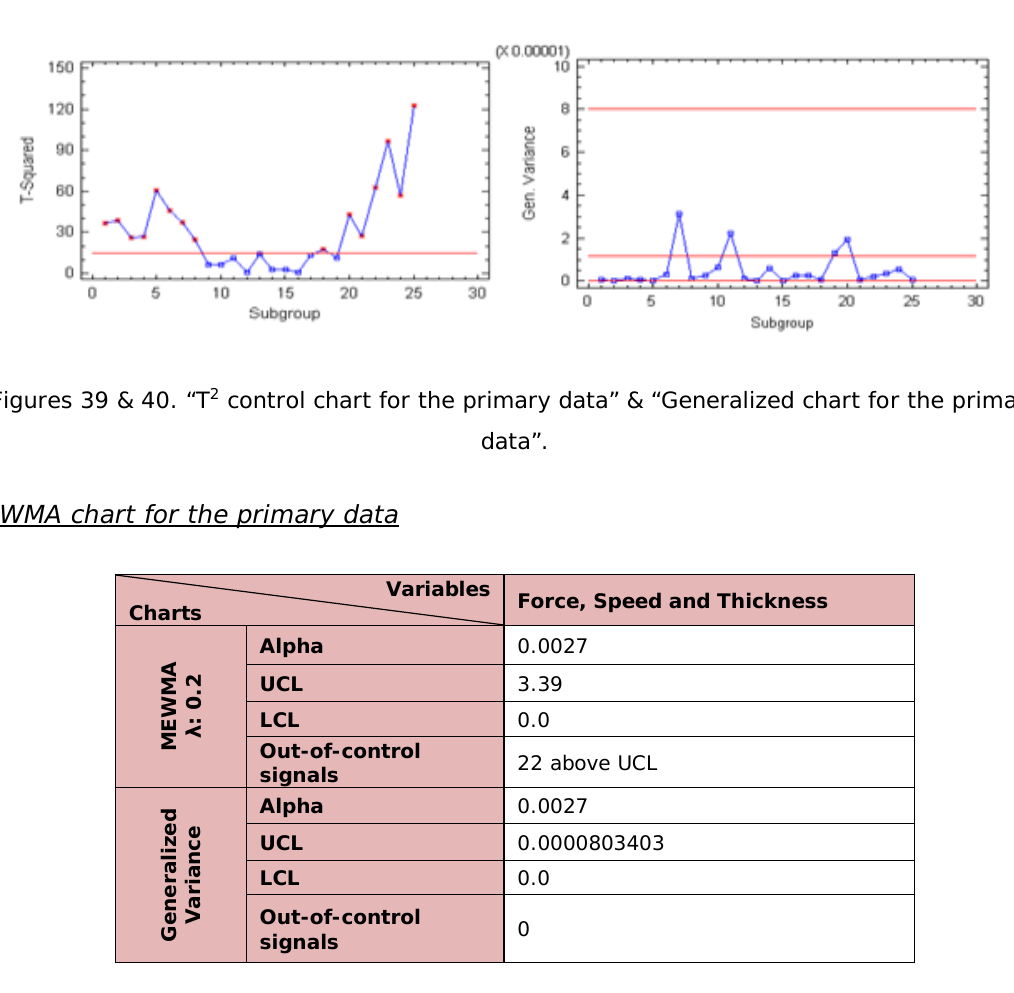
Figure 38. “Control ellipsoid for T 2 chart for the primary data”.